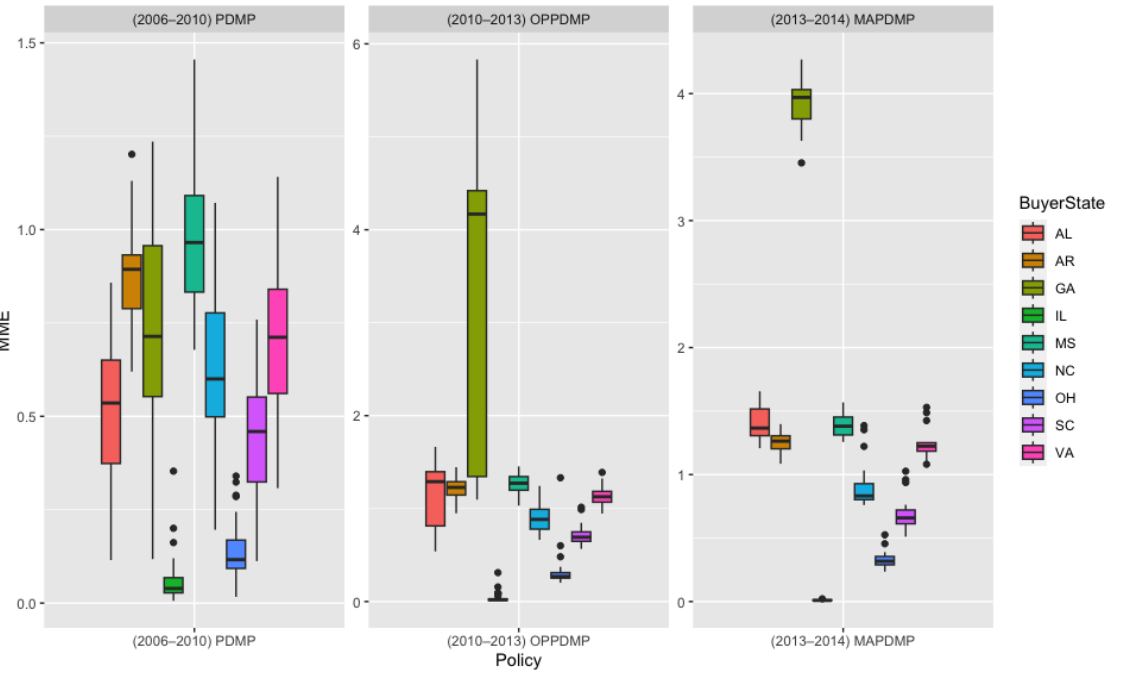
Figure 4. Amount of PCPV from distributors in TN to neighbor states after implementation of each PDMP policy in TN, excluding manufacturing buyers Source: